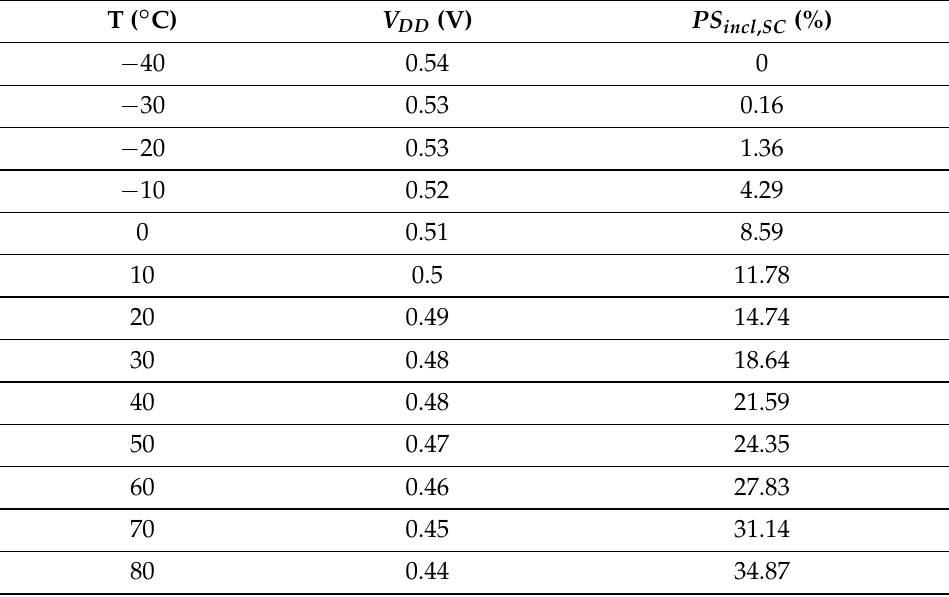
Figure 5. Graph of the result of SC simulations. Table 2. Results of final power savings when the power consumption of SC P SC is included, PS incl , SC